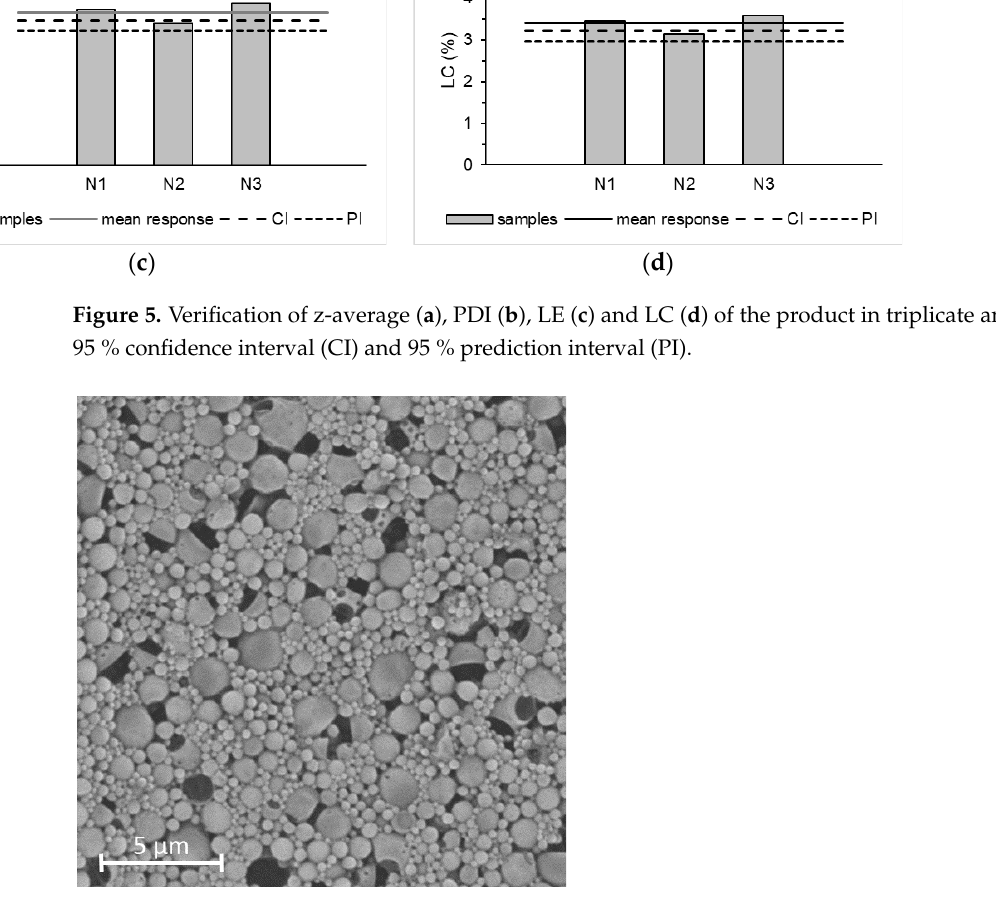
Figure 6. SEM-pictures of PLGA-NP produced with optimised parameters from the response sur- face design at 7000-fold magnification. design at 7000-fold